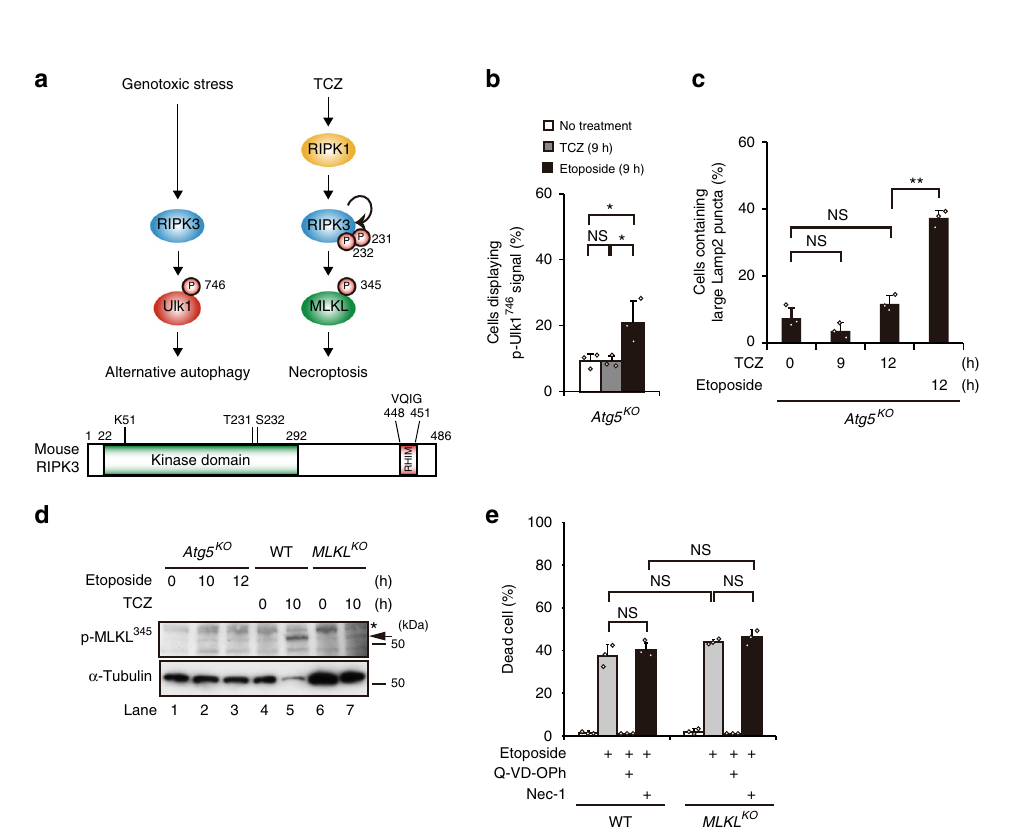
Fig. 5 Absence of crosstalk between TCZ-induced necroptosis and etoposide-induced alternative autophagy. a (Upper fi gures) Schematic model of RIPK3-dependent alternative autophagy and TCZ-induced necroptosis. Genotoxic stress induces alternative autophagy via RIPK3-dependent Ulk1 phosphorylation at Ser 746 . TCZ induces necroptosis via RIPK1, RIPK3, and MLKL. (Lower fi gure) Structure of RIPK3. The kinase and RHIM domains are indicated. Amino acid numbers are shown at the top. T231 and S232 are sites phosphorylated by TCZ treatment. b , c p-Ulk1 746 and alternative autophagy are not induced by TCZ treatment. Atg5 KO MEFs were treated with or without the necroptosis-inducing TCZ solution for 9 h, and then immunostained with anti-p-Ulk1 746 and anti-GS28 antibodies or an anti-Lamp2 antibody. The population of cells displaying p-Ulk1 746 signals b and that of cells containing large Lamp2 puncta ( ≥ 2 µ m) c was calculated ( n ≥ 100 cells). Data of cells treated with etoposide are shown as a positive control. Representative images are shown in Supplementary Fig. 14. In b , no treatment vs. etoposide: p = 0.0293, TCZ vs. etoposide: p = 0.0293. In c , TCZ 0 h vs. TCZ 9 h: p = 0.4194, TCZ 0 h vs. TCZ 12 h: p = 0.2938. d MLKL is not activated in etoposide-treated Atg5 KO MEFs. The indicated MEFs were treated with etoposide (10 µ M) or TCZ for the indicated times, and phosphorylated MLKL was analyzed by western blotting using an anti-p-MLKL 345 antibody. The p-MLKL signal (arrow) was observed only in TCZ-treated WT MEFs (lane 5). The asterisk indicates a nonspeci fi c band. e Induction of apoptosis, but not necroptosis, by etoposide treatment. The indicated MEFs were treated with etoposide (10 µ M) together with Q-VD-OPh (50 µ M) or Nec-1 (30 µ M) for 16 h, and the population of dead cells was analyzed by the PI uptake assay. WT etoposide vs. WT etoposide/Nec-1: p = 0.864, WT etoposide vs. MLKL KO etoposide: p = 0.1024, WT etoposide/Nec-1 vs. MLKL KO etoposide/Nec-1: p = 0.1791. MLKL KO etoposide vs. MLKL KO etoposide/Nec-1: p = 0.9628. In b , c , and e data are shown as the mean ± SD ( n = 3). Comparisons were performed using one-way ANOVA followed by the Tukey post-hoc test. ** p < 0.01; NS: not signi fi cant. Source data are provided as a Source Data fi le. (Supplementary Fig. 25), indicating that p-Ulk1 746 -dependent alpha5 as an example of an endogenous cargo that is alternative autophagy plays a role in eliminating undelivered traf fi cked by the Golgi. Integrin alpha5 mostly localized to VSVG – GFP in etoposide-treated MEFs. focal adhesions in Atg5 KO MEFs (Fig. 10a). Upon the addition of etoposide and E64d/pepstatin, we observed multiple integrin Because VSVG – GFP is an arti fi cial substrate used to alpha5 puncta encircled by Lamp1 (Fig. 10a, image 9), which monitor Golgi traf fi cking, we further analyzed integrin NATURE COMMUNICATIONS| (2020) 11:1754